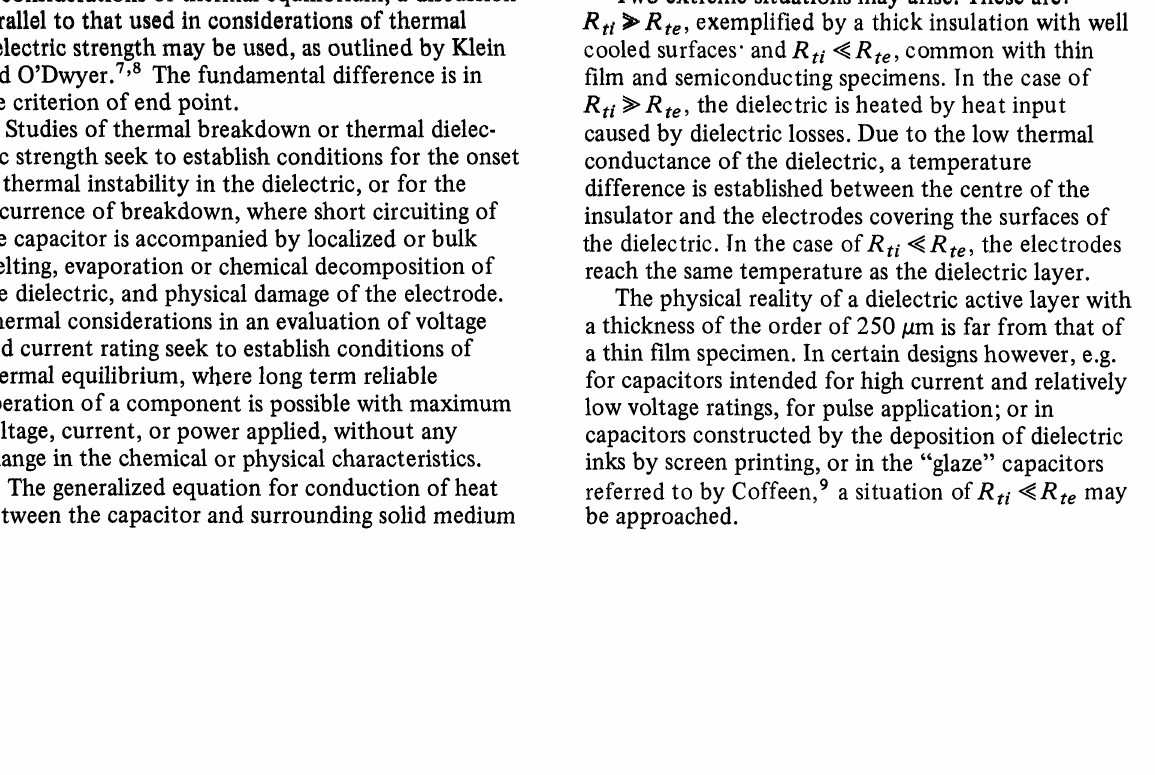
MHz FIGURE lb Quality-factor vs. frequency characteristics of monolithic ceramic capacitor test devices. Type b) device. Capacitance: 41.8 pF. Measurements of chip: Length Width: 3.0 mm (0.118 in), Thickness: 2.54 mm (0.100 in)